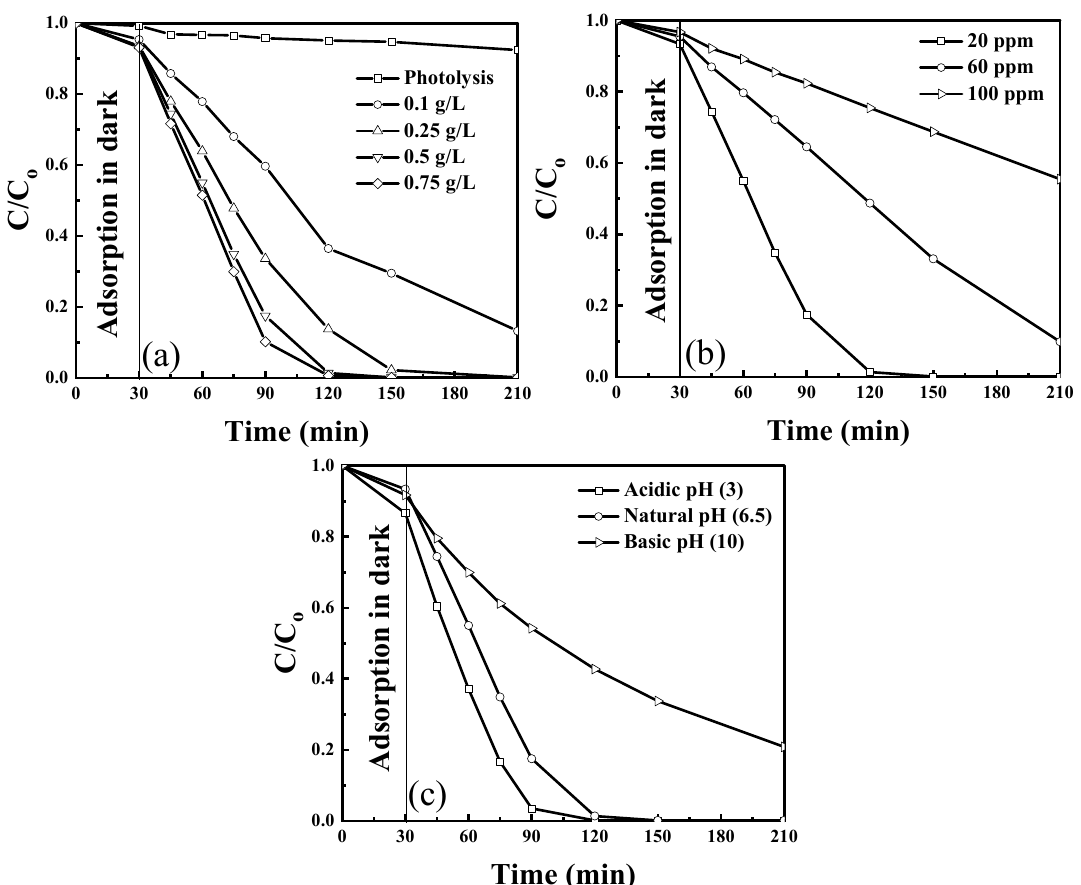
Figure 5. Phenol degradation at preselected ( a ) catalyst concentration (at 20 ppm and natural pH) ( b ) pollutant concentration (at 0.5 g/L and natural pH), and ( c ) pH of the solution (at 0.5 g/L and 20 ppm); airflow = 50 mL/min. Reproduced with permission from [18].